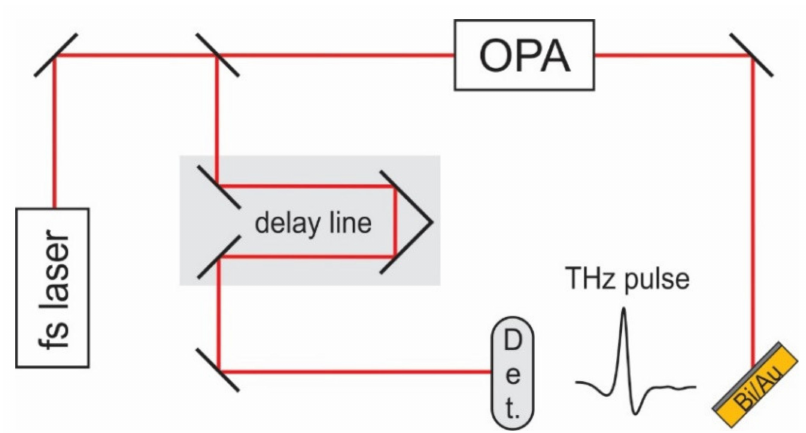
Figure 4. Terahertz time-domain spectroscopy